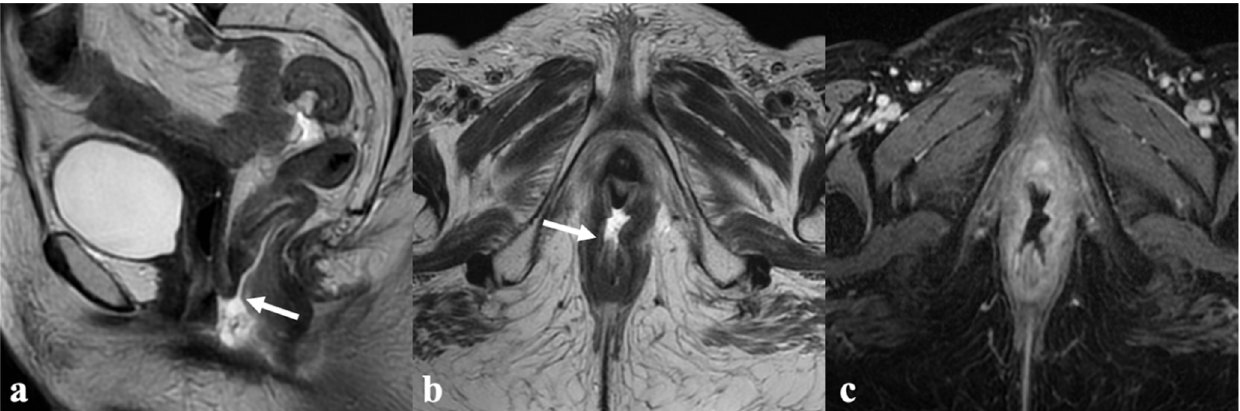
Figure 9. Urethrovaginal fistula after CRT. An 87-year-old patient who received multiple treatments (both surgery and CRT) for recurrent vulvar cancer, presenting with tissue loss in the urethrovaginal space resulting in a fluid-filled communication between the urethra and the lower third of vagina (( a , b )—black arrow) with marked peripheral enhancement ( c , d ), consistent with a fistula.